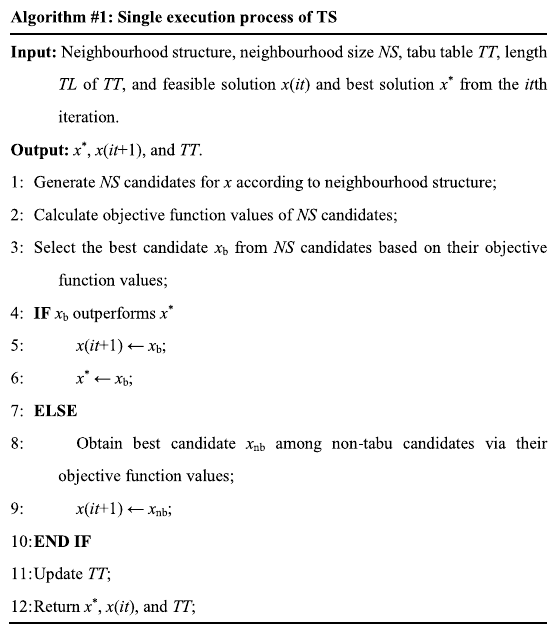
Table 1 The basic framework of single execution process for